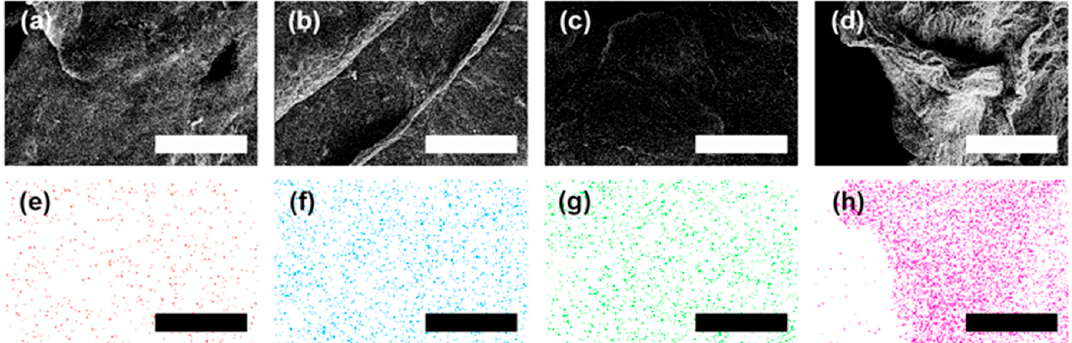
Figure 5. SEM images of ( a ) Pd, ( b ) Pt, ( c ) Ni, and ( d ) Sn loaded rGO aerogels and the corresponding EDS spatial mapping images of loaded ( e ) Pd, ( f ) Pt, ( g ) Ni, and ( h ) Sn on rGO sheets. The scale bar is 20 μ m.